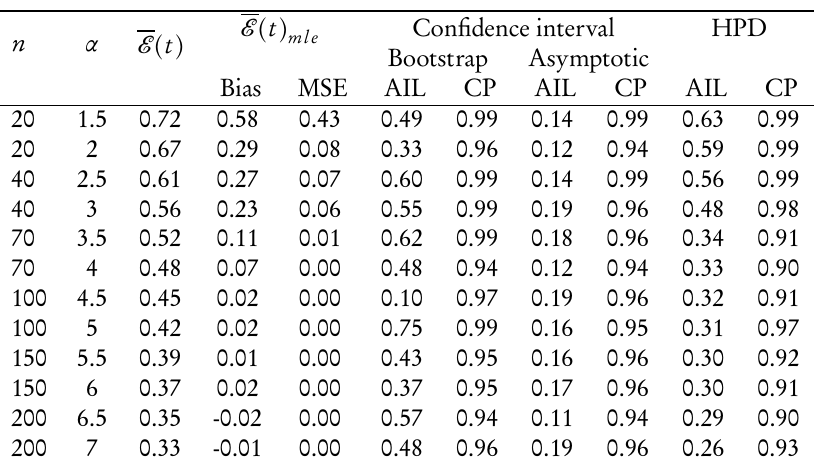
The bias and MSE for MLE and AIL and CP for CI for (cid:69) ( t ) .